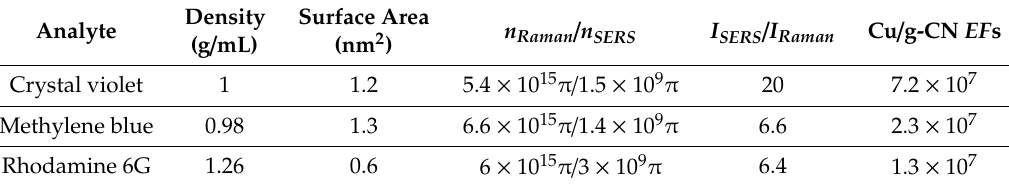
Table 2. Physical characteristics of the analytes used to estimate EF